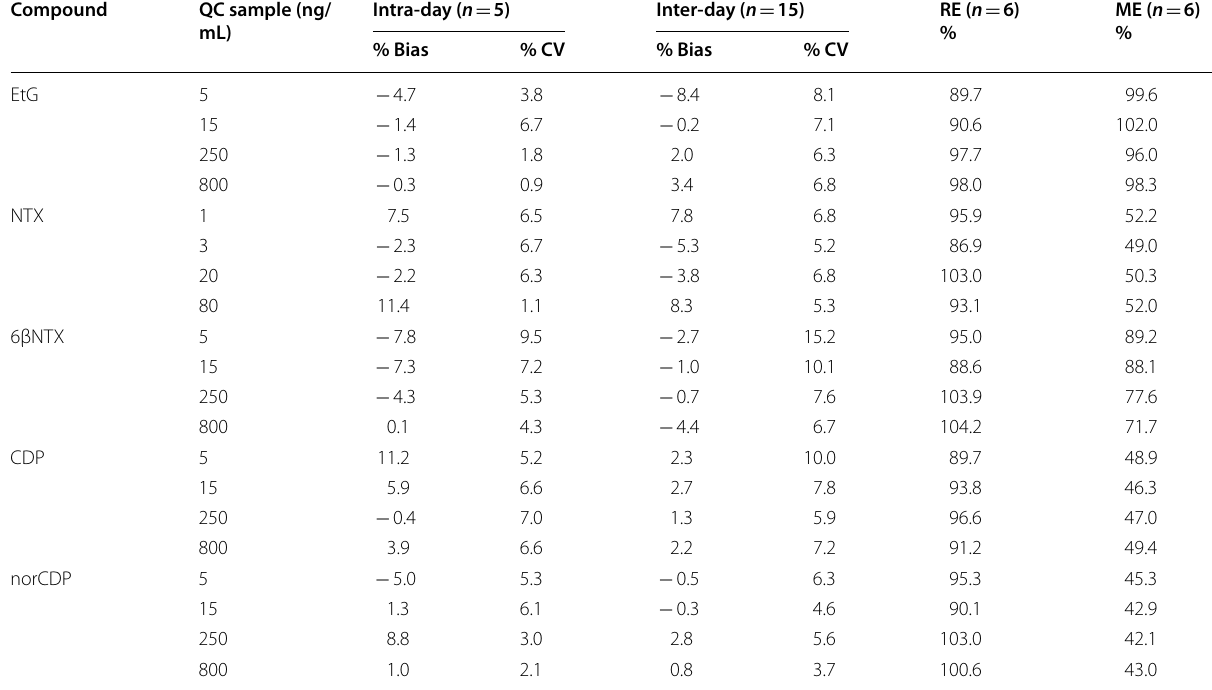
Table 3 Intra- and inter-day accuracy and precision, recovery (RE), and matrix effect (ME) used to validate the method using quality control (QC) samples